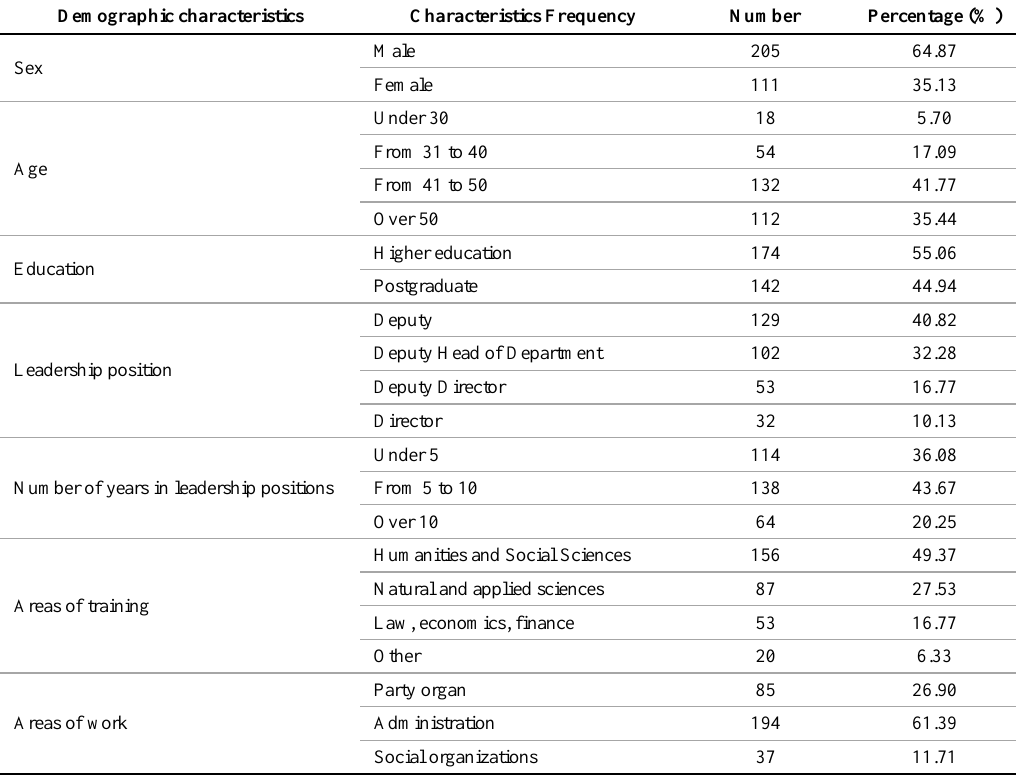
Table 3. Demographic characteristics